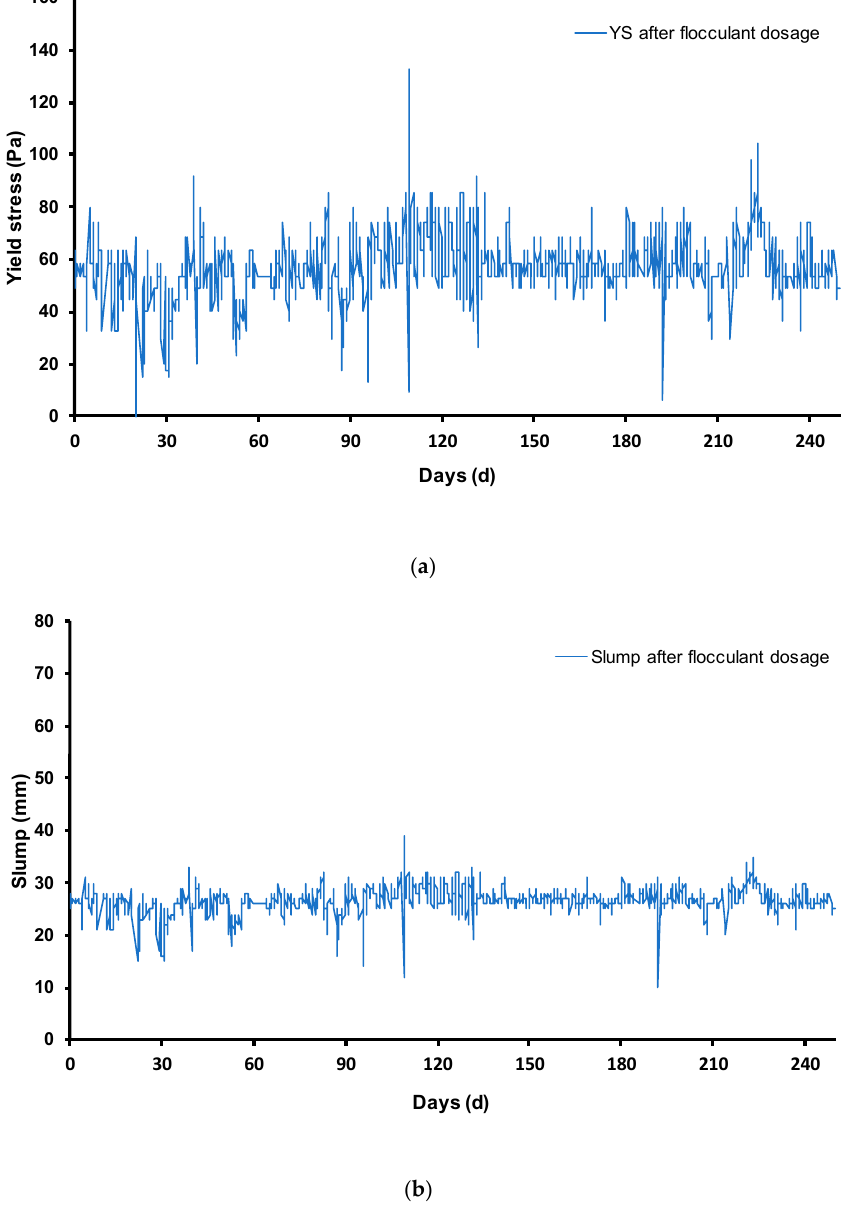
Figure 3. Yield stress measurements ( a ) and slump values ( b ) of the paste tailings after flocculant dosage. The slump tests were used to obtain the yield stress from thickened tailings. The added flocculant (ORIFLOC AP 2020) dosage was 28.3 ± 6.9 g/ton.